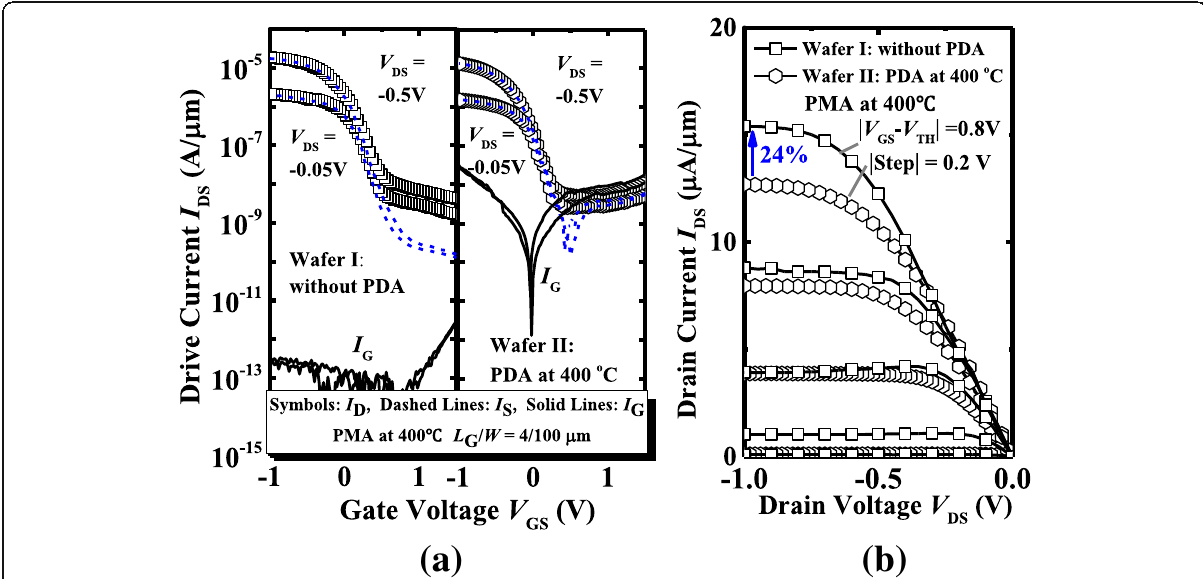
Fig. 7 a I D , I S , and I G vs. V GS curves of Ge pMOSFETs on wafer I and II with PMA at 400 °C. b I DS - V DS curves measured at different V GS - V TH for the devices